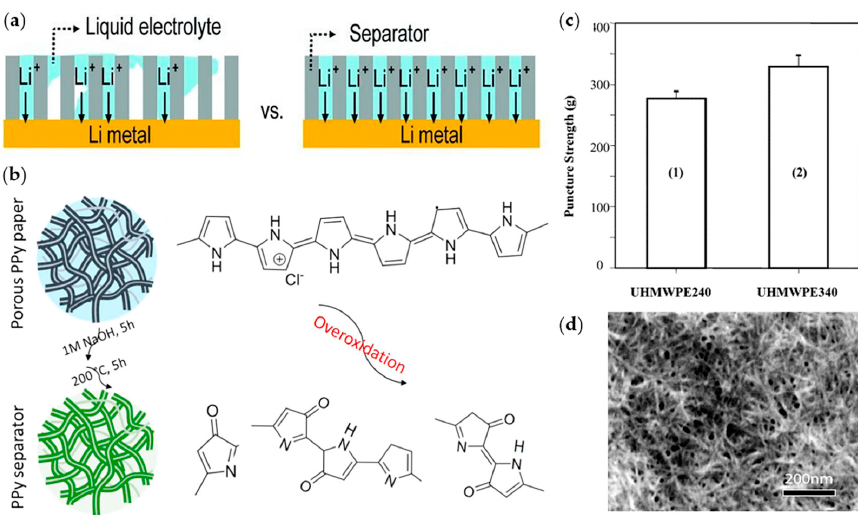
Figure 7. ( a ) Comparison of poor wettability (left) and good wettability (right). Reprinted